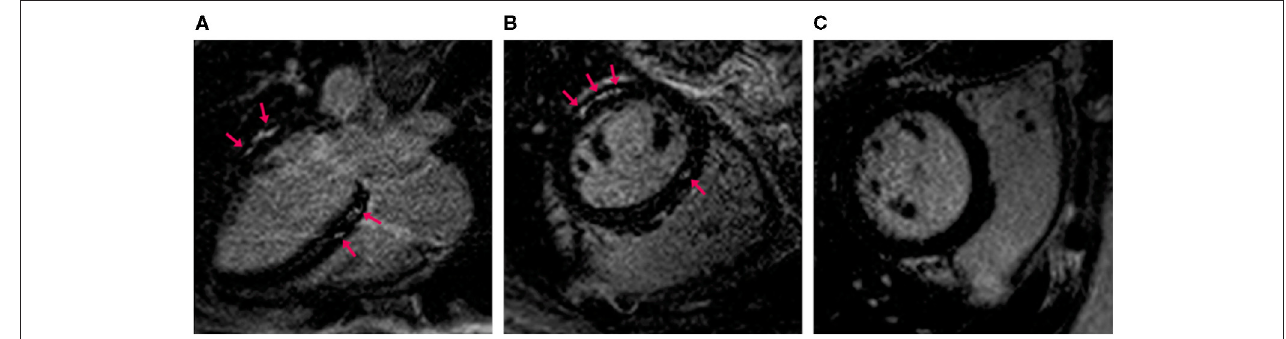
FIGURE 2 | Magnetic resonance images of the heart with late gadolinium enhancement. Long axis (A) and short axis (B,C) images. (A,B) show myocardial fibrosis (arrows) in a 46-year-old woman. (C) shows the corresponding findings in a 42-year-old unaffected woman.